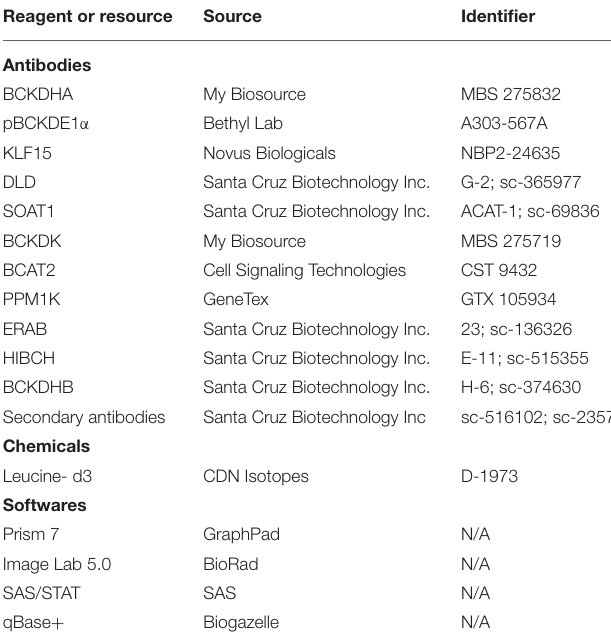
TABLE 7 | Table of key